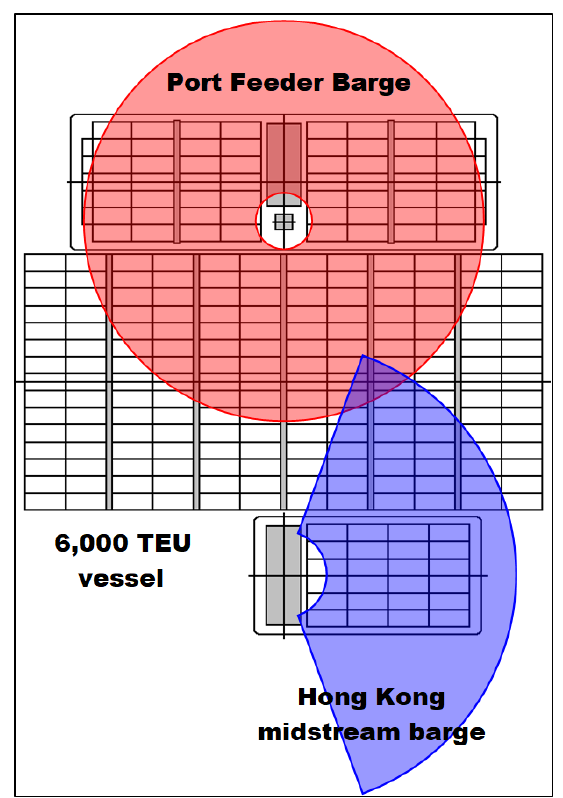
Figure 7: Hong Kong midstream barge vs. Port Feeder Barge - Horizontal Slot Accessibility (serving a 6,000 TEU vessel)